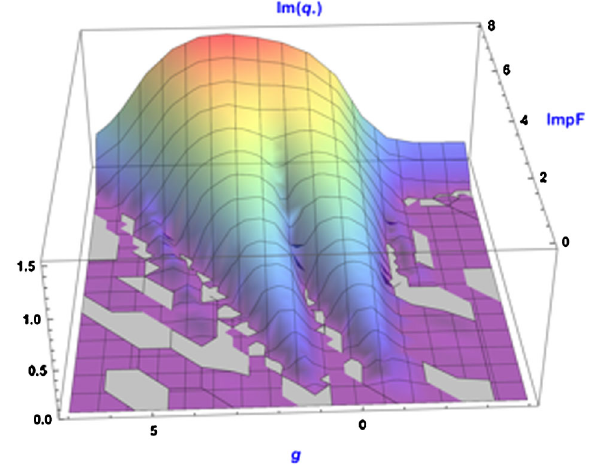
τ Þ − 1 versus s ; its positive s